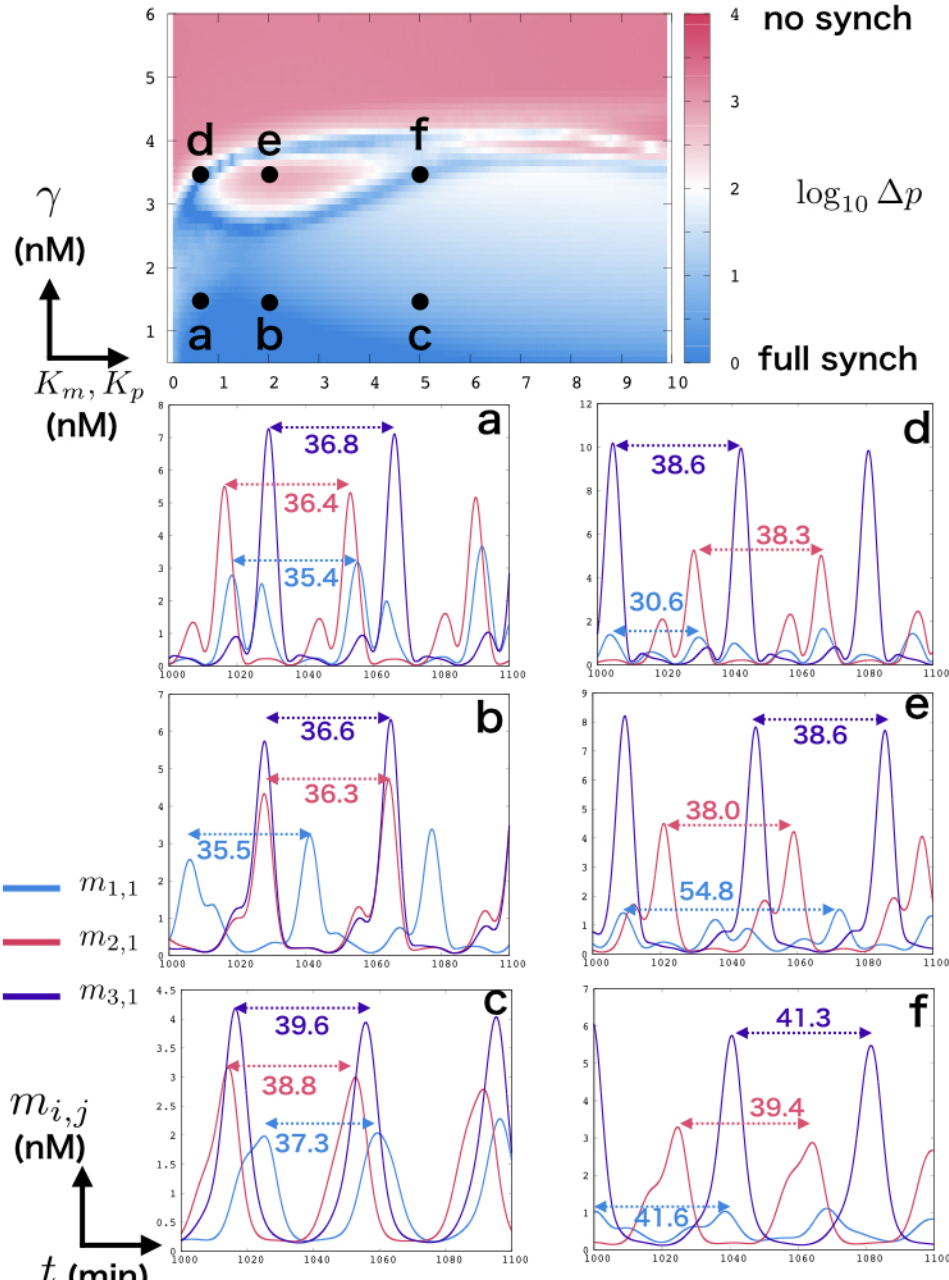
Figure 2. Top: Heatmap of synchronization in the system. The horizontal axis is K m , K p and the ∆ p . Bottom ( a – f ): time-series data for 6 points of interest in vertical axis is γ . The color is set by log 10 the parameter space. Light blue is m 1,1 , red is m 2,1 and purple is m 3,1 . Arrows indicate the respective period of the